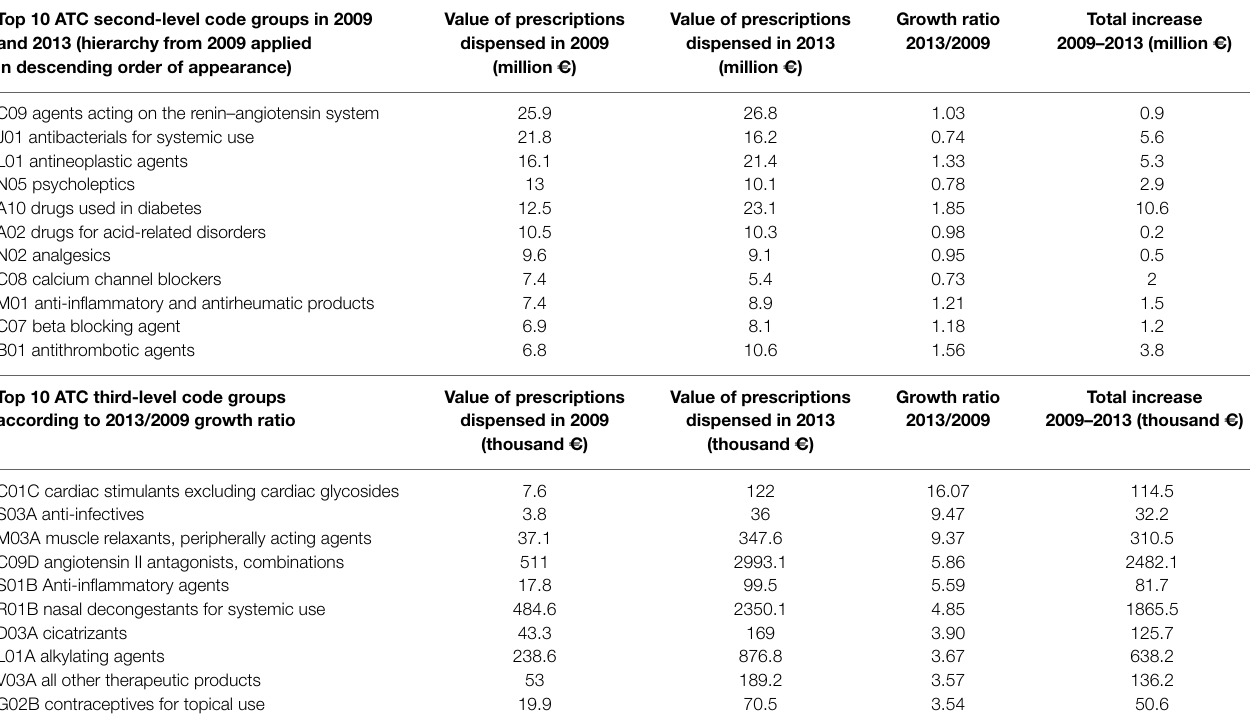
TABLE 1 | Top 10 ATC second- and third-level drug code groups ranked in 2009 and 2013 according to value-based turnover of dispensed medicines and its growth ratio 2013/2009 a . Top 10 ATC second-level code groups in 2009 and 2013 (hierarchy from 2009 applied in descending order of